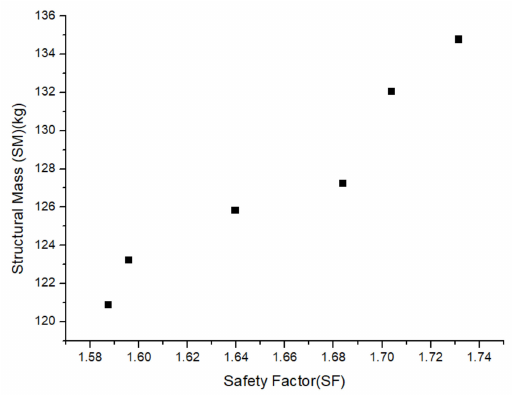
Figure 9. Split drape coupling plate detailed design solution Pareto solution set.